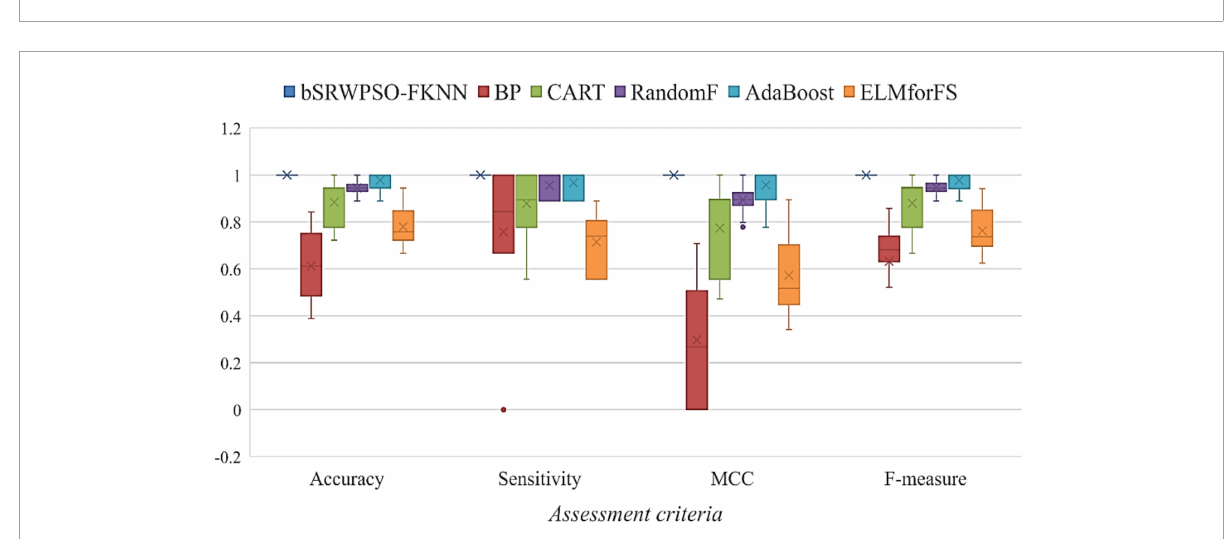
FIGURE16 Evaluation results for different combinations.